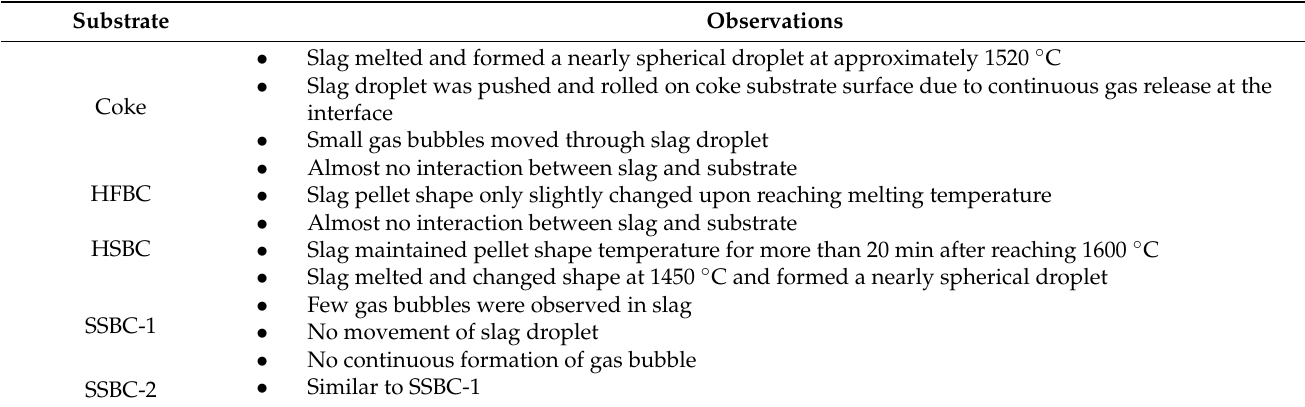
Table 11. Summary of interfacial interaction observations.